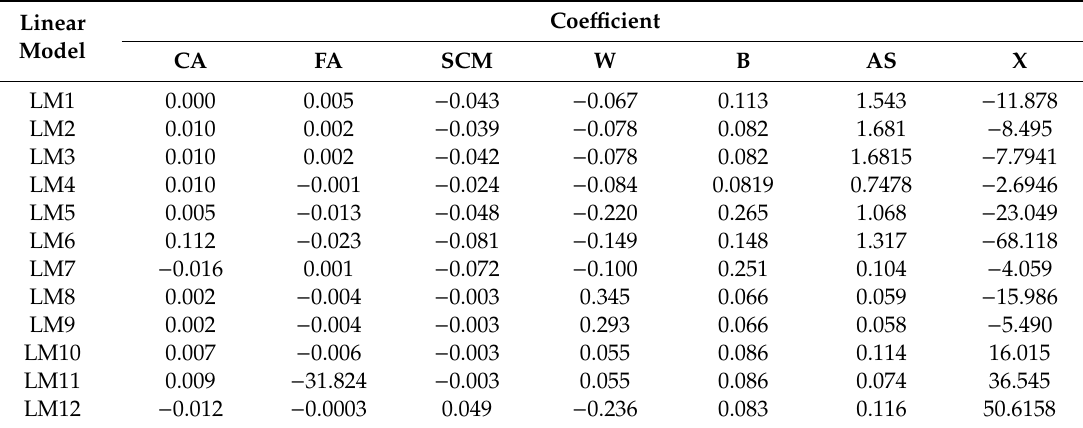
Table A1. Input coe ffi cients of M5p for CS